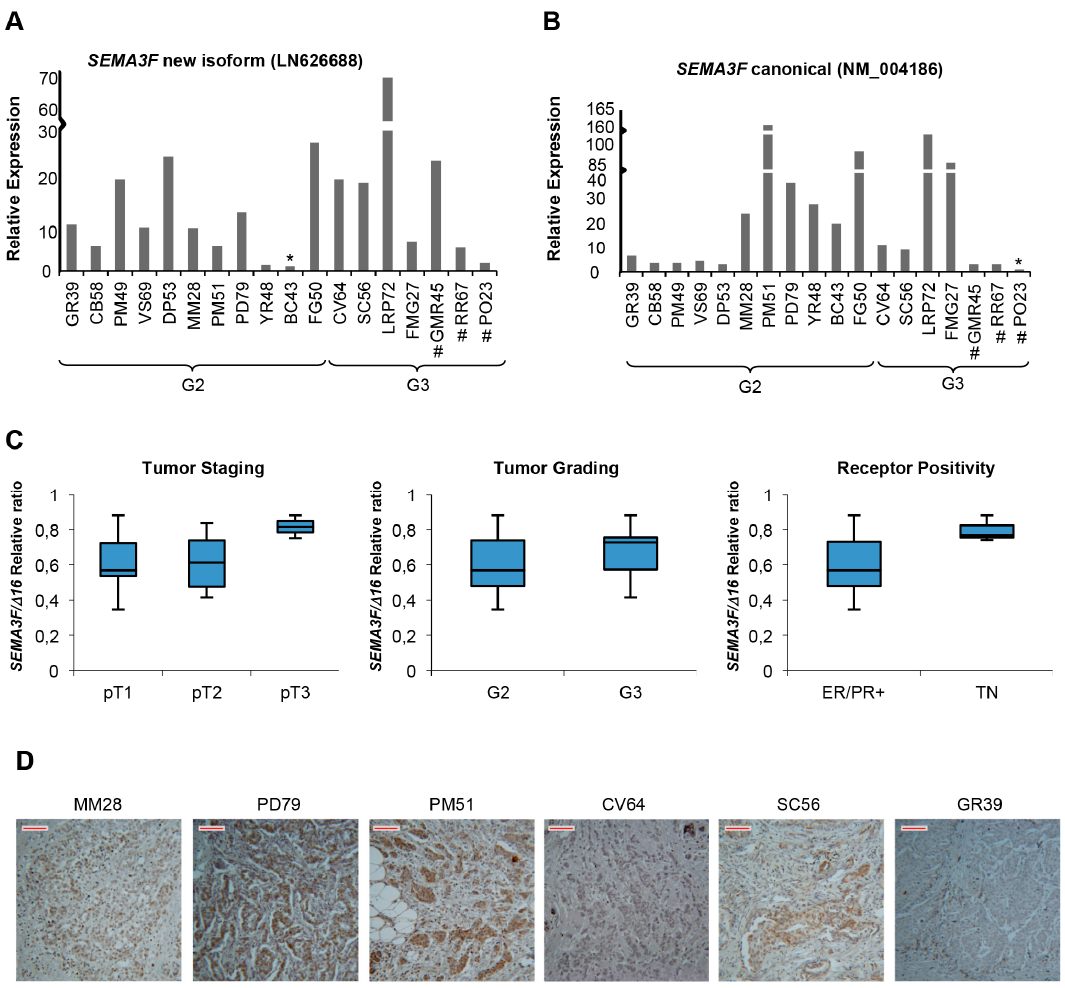
Figure 6. Semaphorin 3F expression in BC tumor biopsies ( n = 18). ( A , B ) qRT-PCR analysis of the new (LN626688) and the annotated (NM_004186.3) SEMA3F transcripts, respectively. Samples have been ordered according to tumor grade (G2, G3); # indicates Triple Negative biopsies; asterisks (*) indicate the sample with the lowest absolute expression, used as reference; ( C ) Relative ratio of Δ C t values between skipping and canonical mRNA isoforms of SEMA3F across breast cancer subtypes. TNM: pT1 ( n = 7); pT2 ( n = 9); pT3 ( n = 2). Tumor grade: G2 ( n = 11); G3 ( n = 7). ER + /PR + ( n = 15); TN (triple negative samples) ( n = 3); ( D ) Six representative images by immunohistochemistry assay on FFPE slices from breast cancer specimens are shown; N-terminal anti-Sema3F (that recognizes both the canonical and the new splicing variant) primary antibody was used. Scale Bar (in red) value = 33.76 µm.